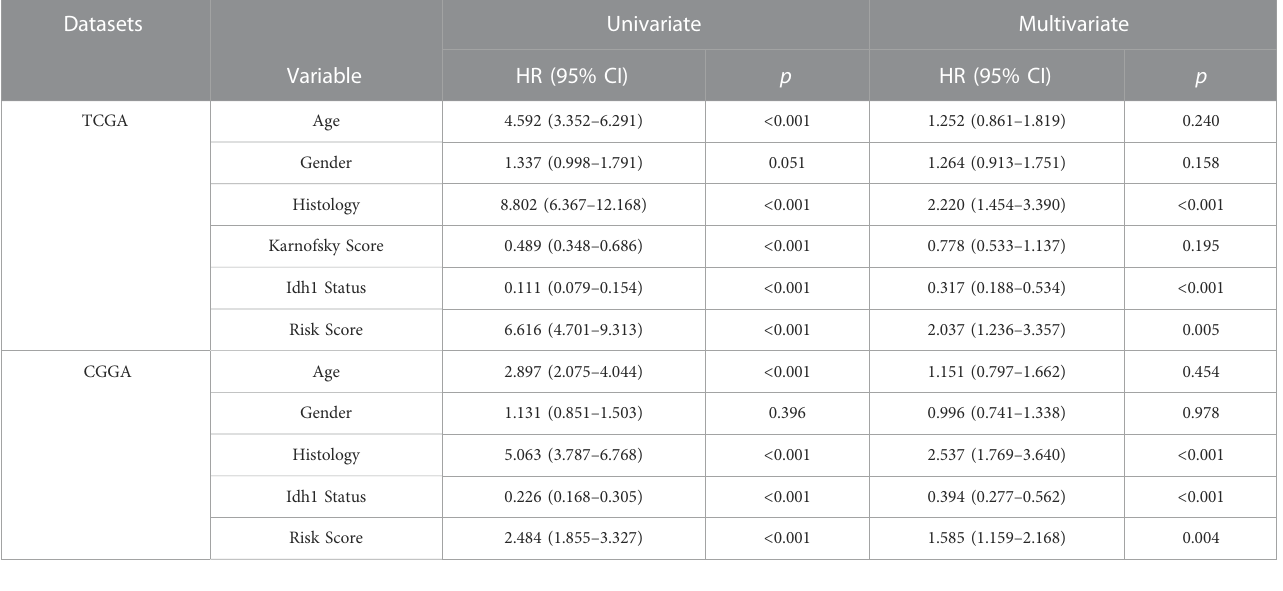
TABLE 2 Univariate and multivariate analysis of the risk scores in TCGA database and CGGA database.